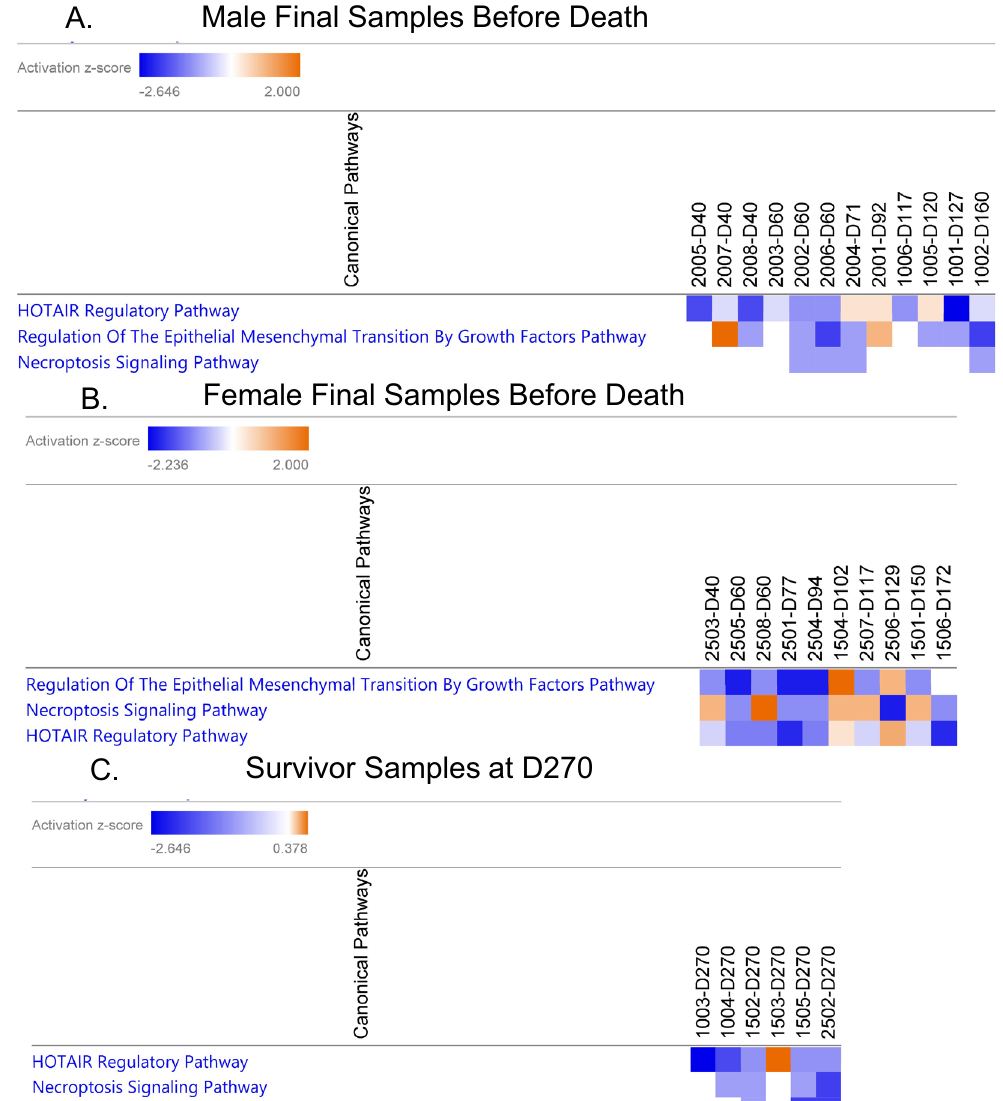
Figure 6. Pathway analysis via IPA for males at their latest time point sequenced before death ( A ), females at their latest time point sequenced before death ( B ) and surviving animals at Day 270 ( C ). A z-score absolute value cutoff of 0.1 was applied, with orange indicating upregulation and blue representing downregulation. Animals in 8A and 8B are listed in order of increasing length of